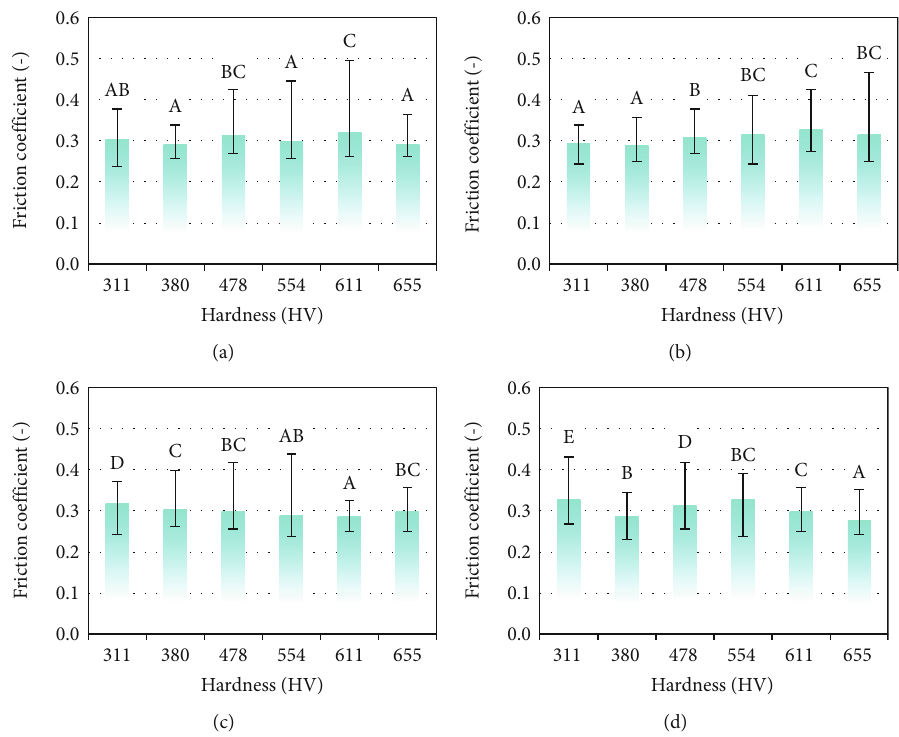
Figure 5: The coe ffi cient of static friction (mean value and minimum – maximum value) of cereal kernels on friction plates with di ff erent hardness and parallel surface orientation: (a) barley; (b) oats; (c) rye; (d)